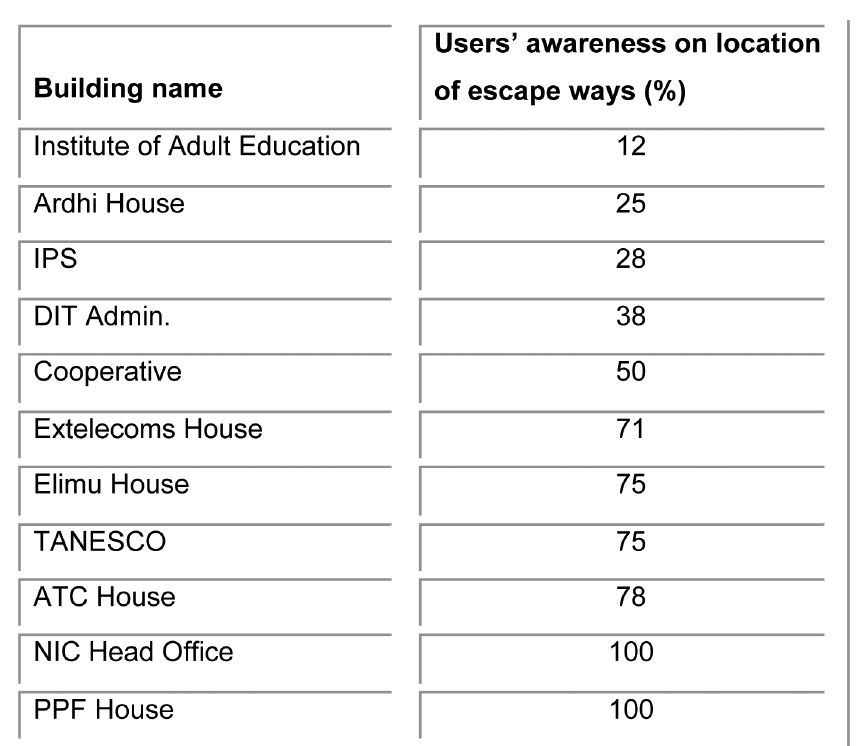
Table 4. Building users’ awareness of escape